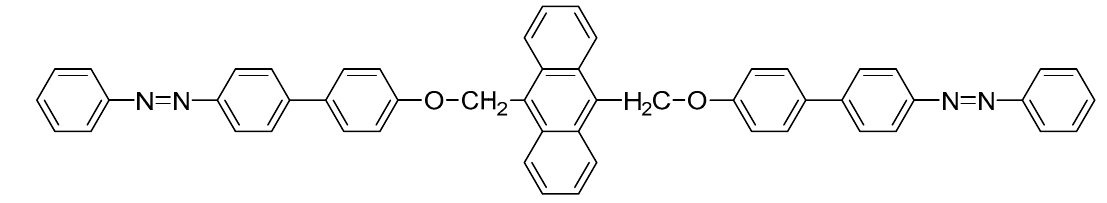
Figure 1. The structural formula of BPA.